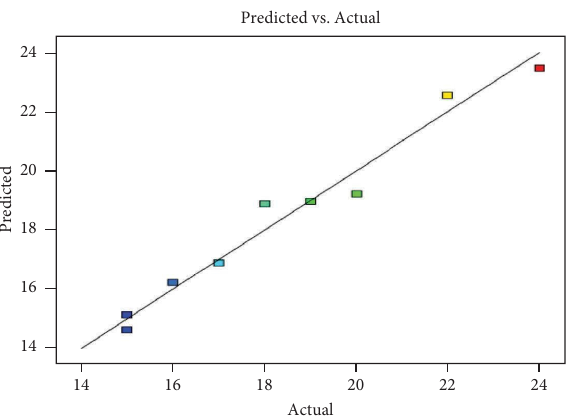
Figure 9: Simulated and actual outcome for compressive strength.